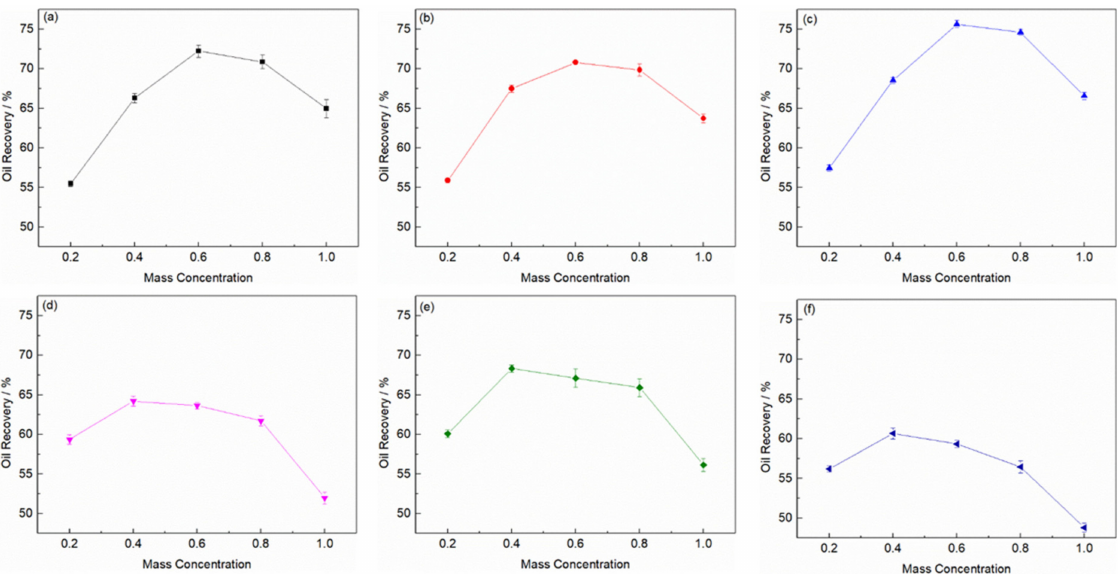
Figure 2. Oil recovery rate assisted with ionic liquid ( a ) [Emim][BF 4 ]; ( b ) [Emim][TA]; ( c )[Emim][N(CN) 2 ]; and deep eutectic